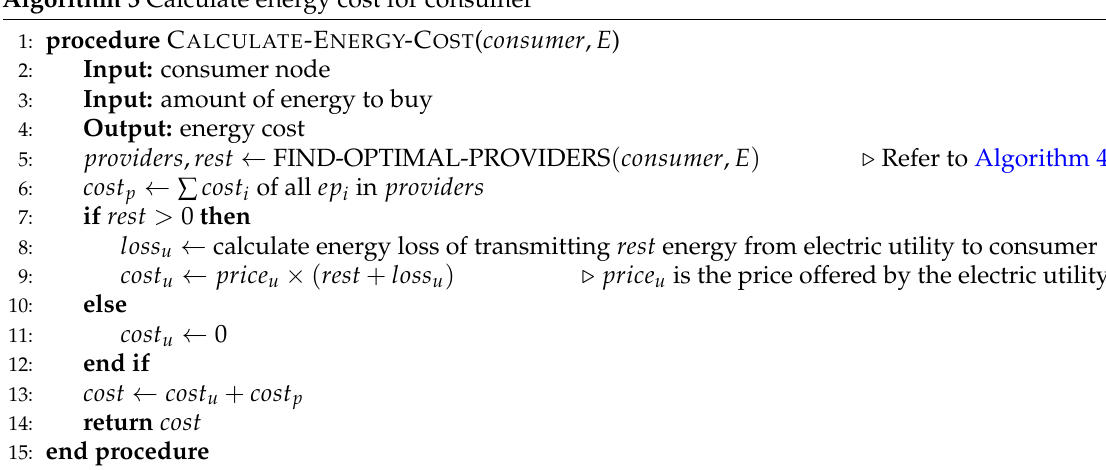
Algorithm 5 Calculate energy cost for